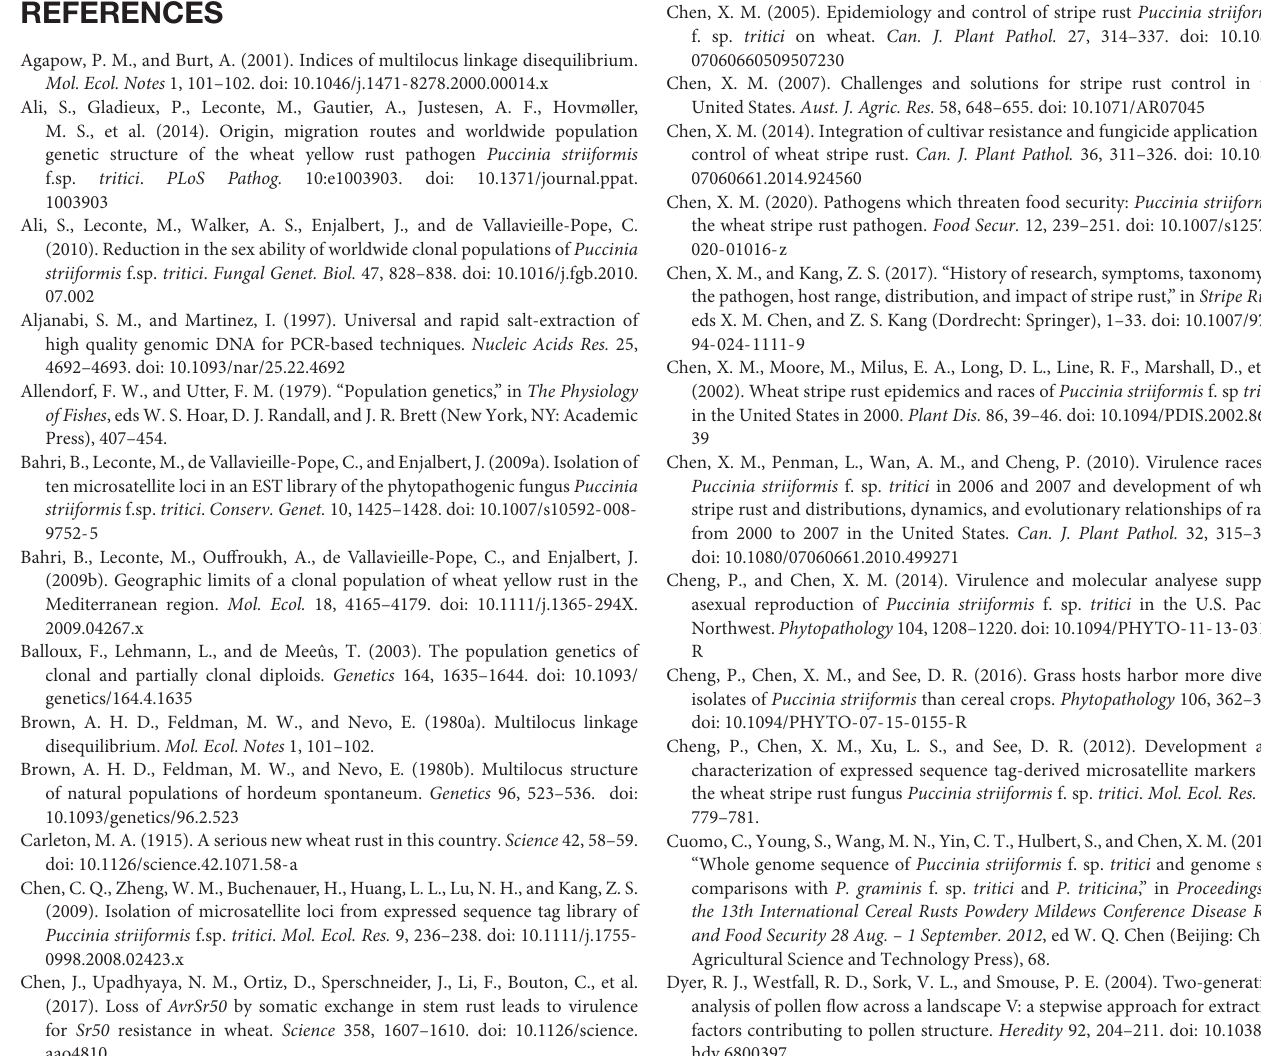
lines outside the distributions. The hypothesis of no linkage among markers is rejected, indicating a clonal